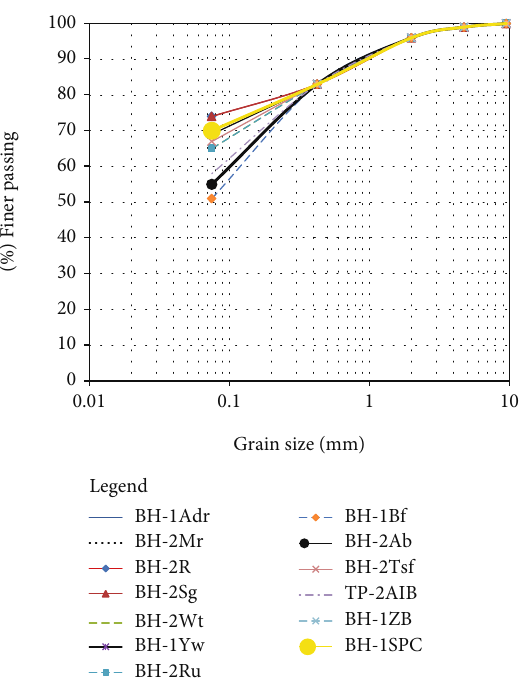
Figure 14: Grain size distribution curves of soil in the study Table 6: Summarized geotechnical results of soils in the study area.